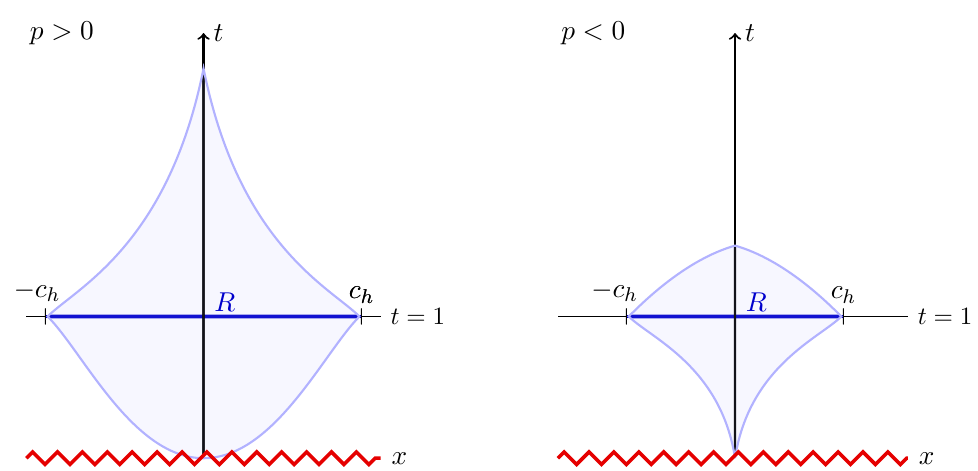
2 contacts the singularity (where Figure 2 . The lower tip of D for the region R = [ R d c h , c h ] − R − × we omit the orthogonal directions due to translational invariance). For a super-horizon region R , i.e. , its causal development D ceases to be complete. Amongst the d 1 possible choices one with c > c h R − for the compact direction of R , at least one behaves as in the contracting case of the right